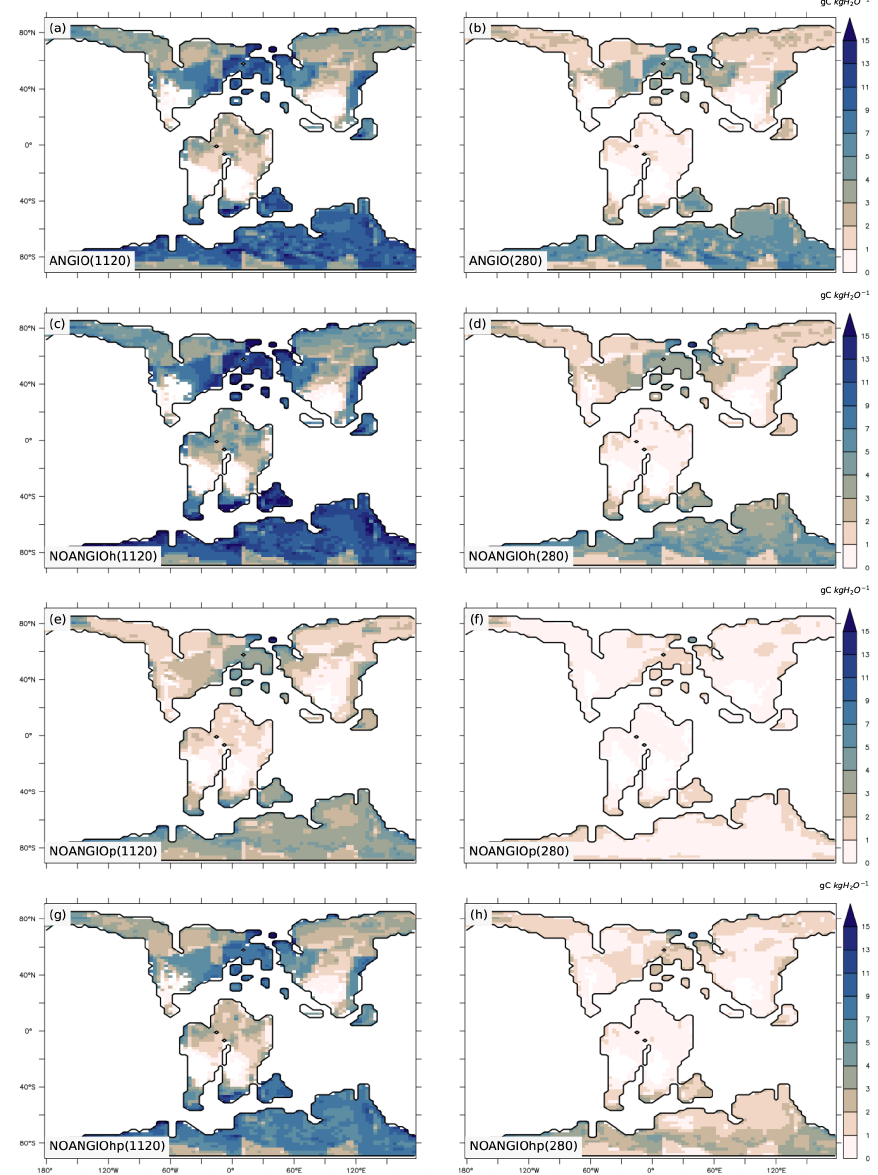
Figure 8. Annual mean WUE (gC kgH 2 O − 1 ) for (a) ANGIO(1120), (b) ANGIO(280), (c) NOANGIOh(1120), (d) NOANGIOh(280), (e) NOANGIOp(1120), (f) NOANGIOp(280), (g) NOANGIOhp(1120) and (h)